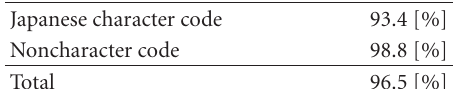
Table 3: Accuracy of translation per node.